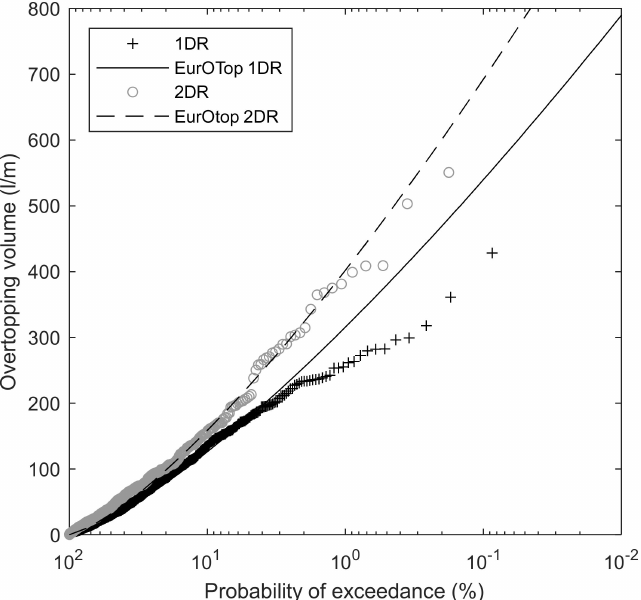
Figure 8. Exceedance probabilities for individual wave overtopping volumes measured between 12 and 24 h of testing ( z WL = 4.9 m) when the crest position was approximately constant. Black crosses represent data for 1DR ( R c /H m 0 = 1.26) and the 2DR data are shown as grey circles ( R c /H m 0 =